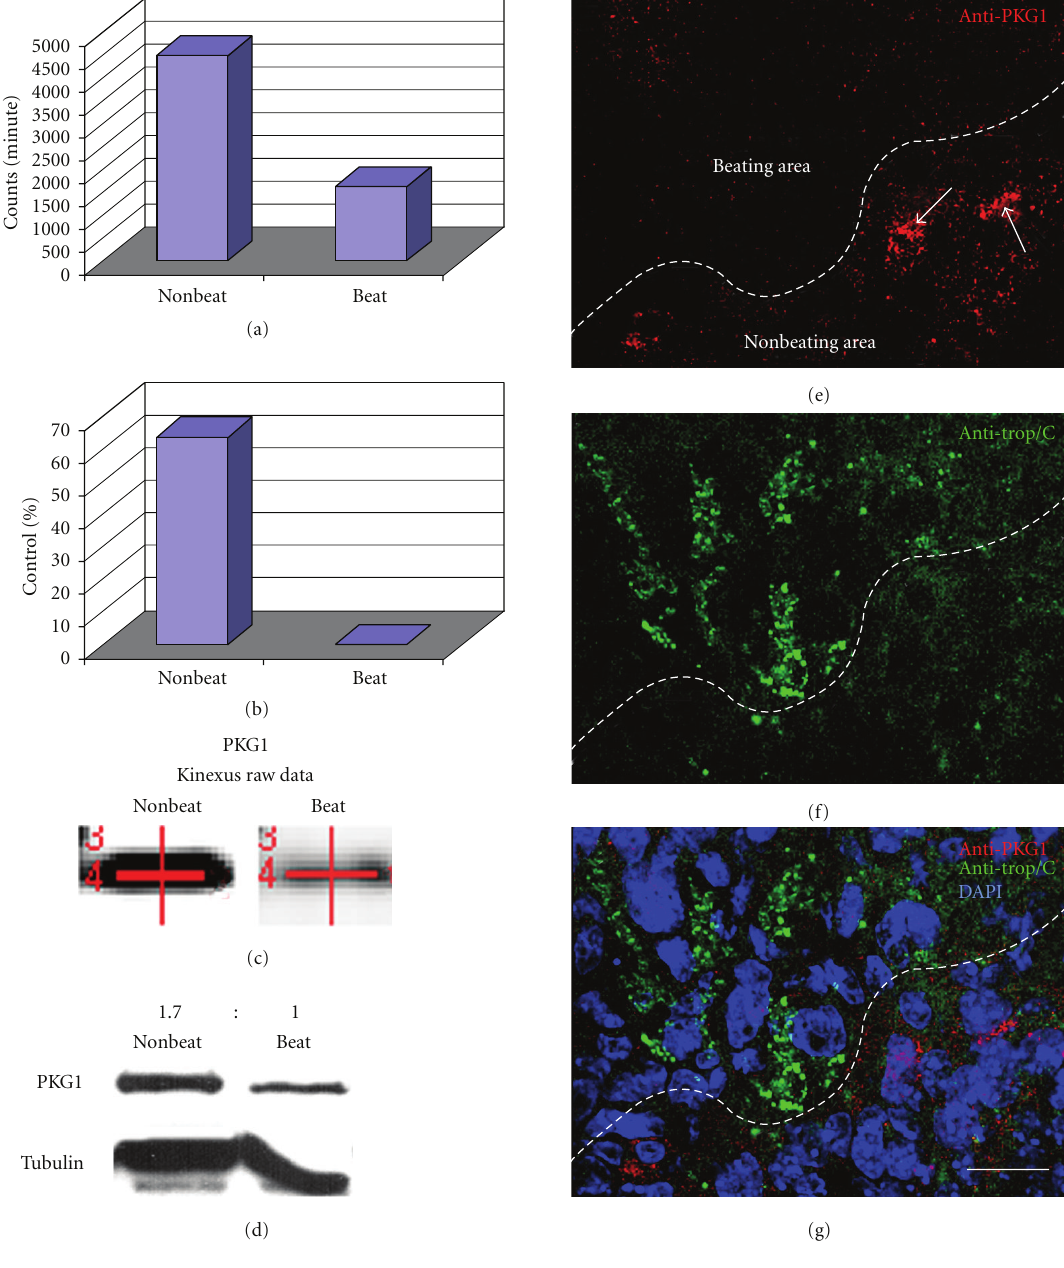
Figure 1: Graphs show raw and normalized data taken directly from the Kinexus protein kinase screen. (a) Kinexus Inc. (http://www.kinexus.ca/) uses a highly sensitive imaging system with a 16-bit camera (Bio-Rad Fluor-S Max Multi-Imager) in combination with quantitation software (Bio-Rad Quantity One) to quantify and analyze the chemiluminescent samples. The resulting trace quantity for each band scanned at the maximum scan time is termed the raw data. As the relationship between scan time and band intensity is linear over the quantifiable range of the signal intensity, the raw data from the scans are normalized to 60 seconds (counts per minute— C.P.M.) for uniformity. (b) After normalization, data are converted to percentages by subtracting the control (Nonbeating) normalized C.P.M. from the experimental (Beating) normalized C.P.M., followed by dividing the di ff erence by the control (Nonbeating) normalized C.P.M. and multiplying by 100. (c) The actual PKG1 bands from the Kinexus report show a stronger signal in beating areas when compared to nonbeating areas. The red lines in (c) are generated and used by the computer to find the correct bands. (d) Followup Western blots confirmed the Kinexus data. A ratio of PKG1 protein levels was calculated by normalizing to tubulin showing that there is 1.7X (69%) more PKG1 in nonbeating areas versus beating areas. (e)–(g) Confocal microscopy of EBs showed higher levels of PKG1 in nonbeating areas, represented by anticardiac troponin (e)–(f), when compared to nonbeating areas. Arrows point to PKG1 within cells negative for cardiac troponin. Scale bar in G = 100